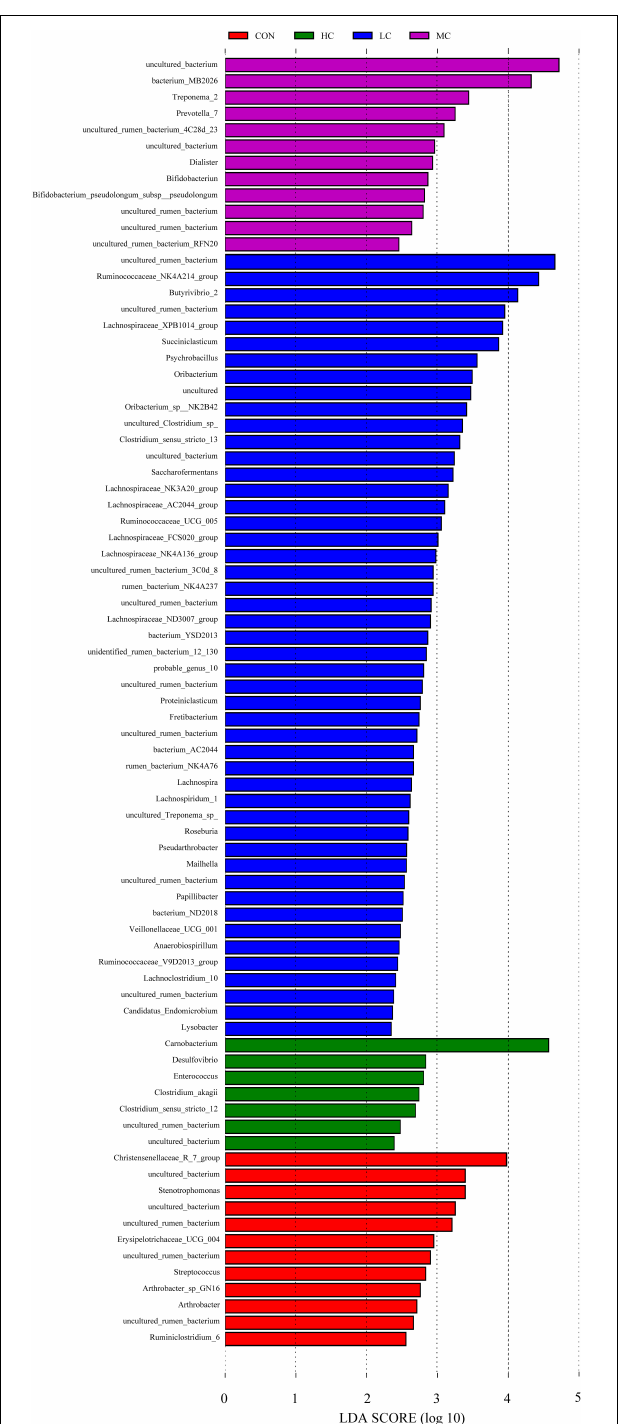
FIGURE 4 | Histogram of LDA score calculated for each taxon ranging from phylum to genus. The LDA scores represent the difference in relative abundance with an exponential fold change of 10 between both communities, indicated by the significant difference in taxa. Red: Taxa abundant in CON, Green: Taxa abundant in HC, Purple: Taxa abundant in MC, Blue: Taxa abundant in LC. CON, C. deserticola at 0%; LC, C. deserticola at 2%; MC, C. deserticola at 4%; HC, C. deserticola at